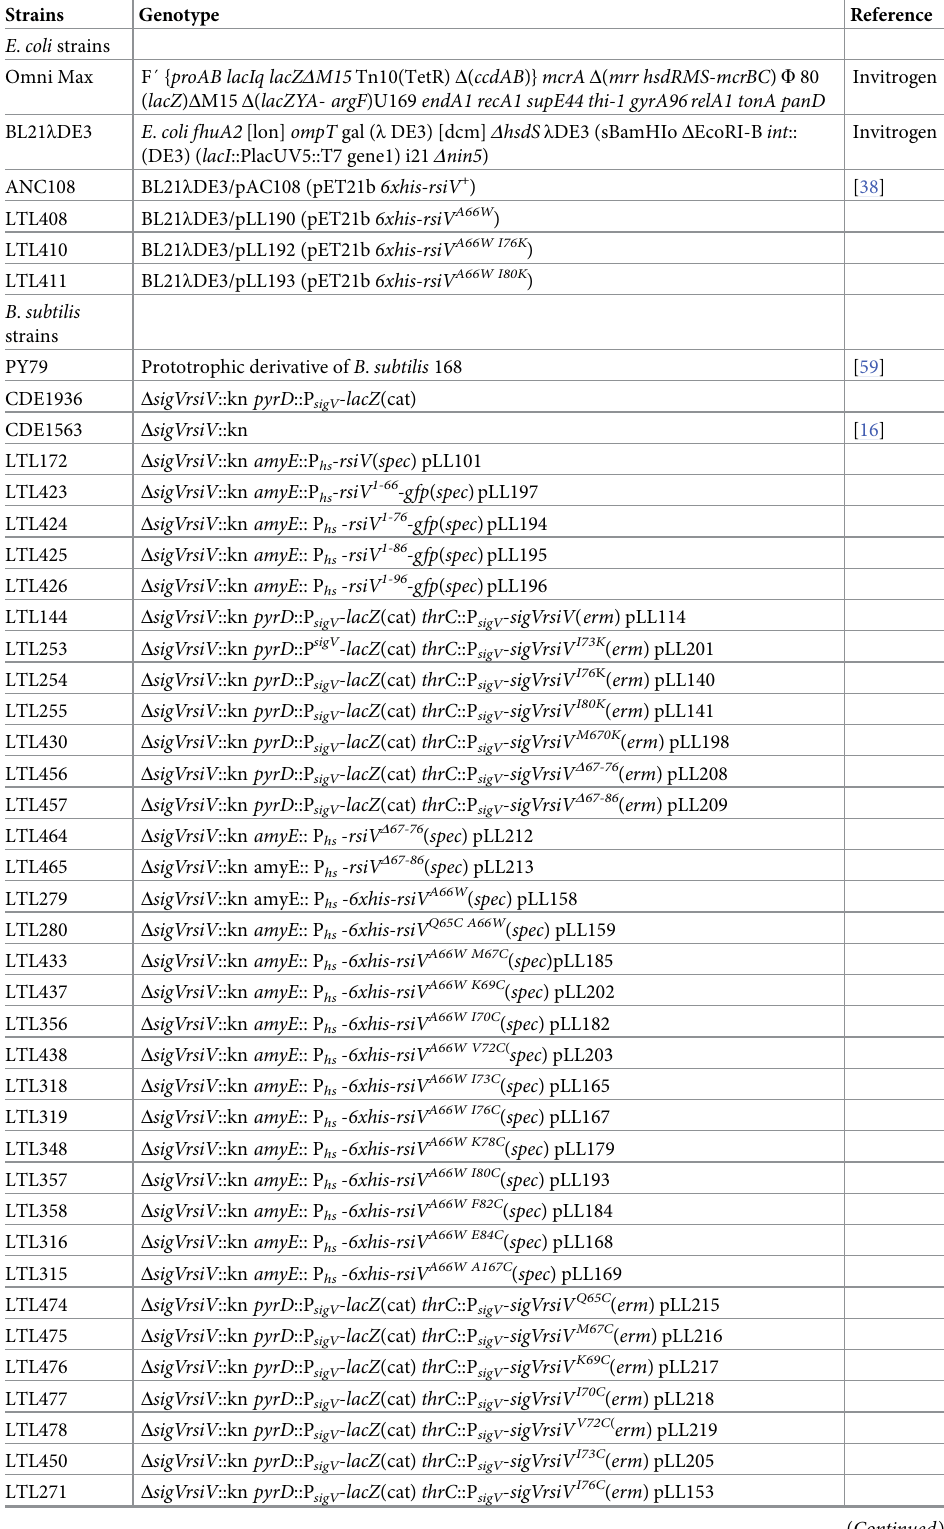
Table 2. Strains list.